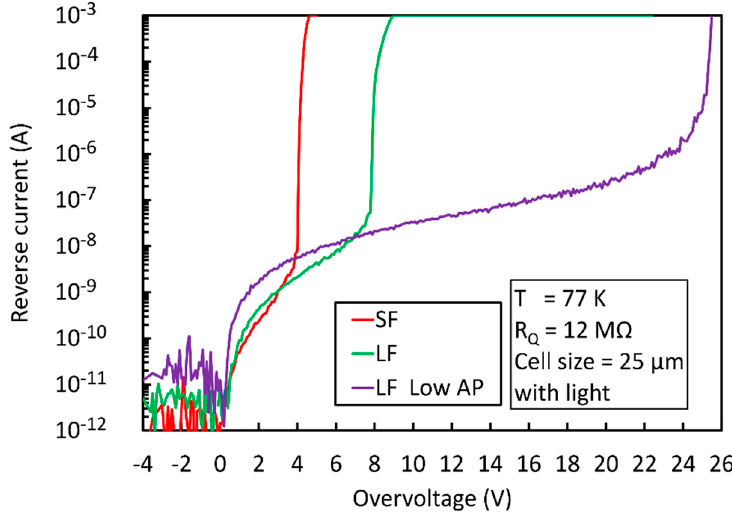
Figure 19. Reverse current-voltage characteristics measured at 77 K for the NUV-SF, NUV-LF and NUV-LF-LowAP SiPM.